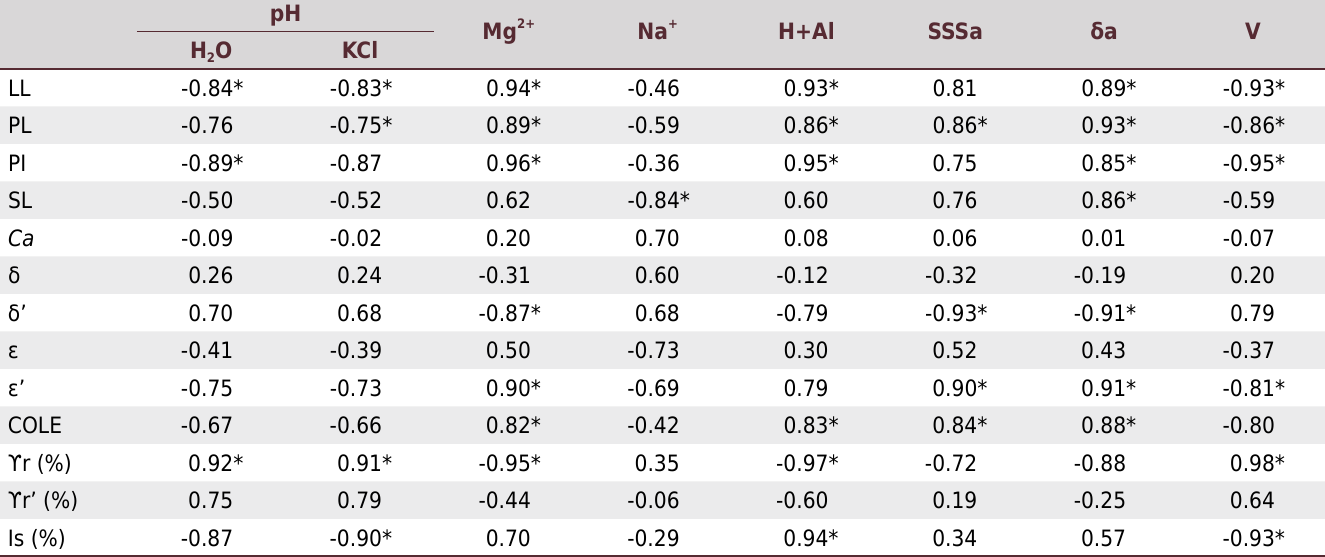
Table 9. Result of the correlation analysis between the geotechnical variables and the variables of chemical and physical characterization of the soils